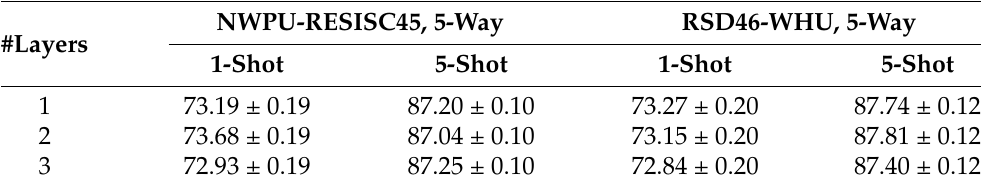
Table 9. Ablation study on the number of layers in Transformer of the proposed embedding adaption module. Results are averaged over 10,000 test tasks with 95% confidence